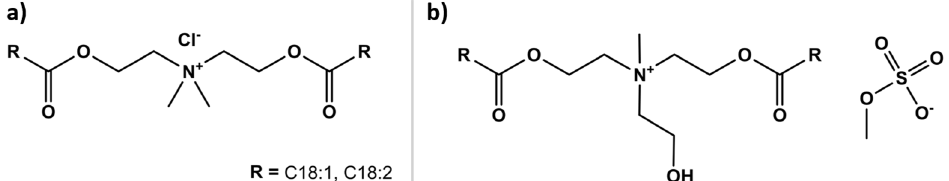
Figure 9. Chemical structure of two commercially available plant-based esterquats derived from sunflower seed oil used in hair conditioners formulations: ( a ) disunfloweroylethyl dimonium chloride and ( b ) dioleoylethyl hydroxyethylmonium methosulfate.